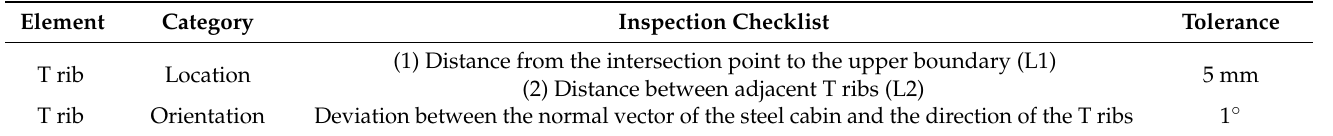
Table 2. Assessment checklist items for T